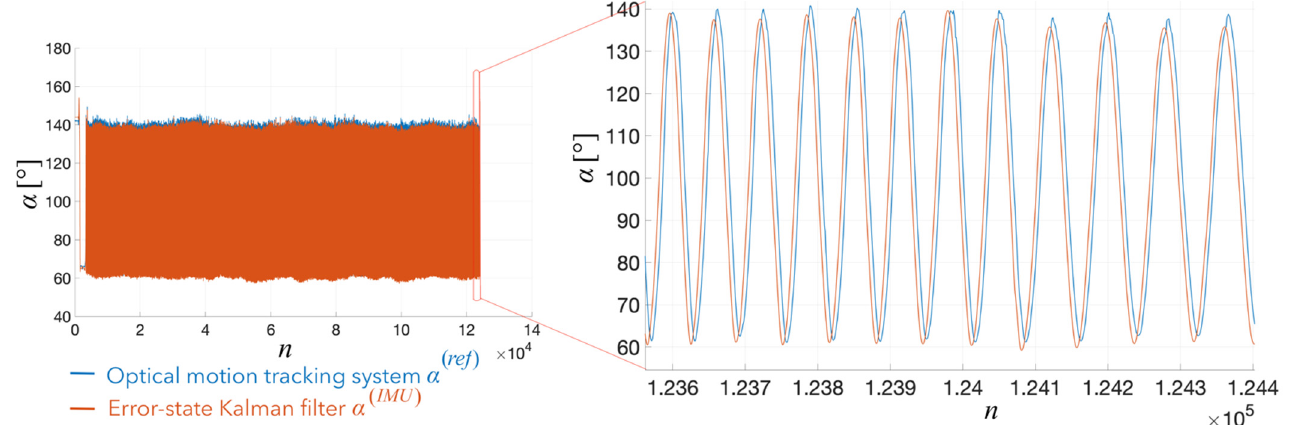
Figure 3. Desynchronisation of results for longer measurement trials due to systems’ clock-differences.